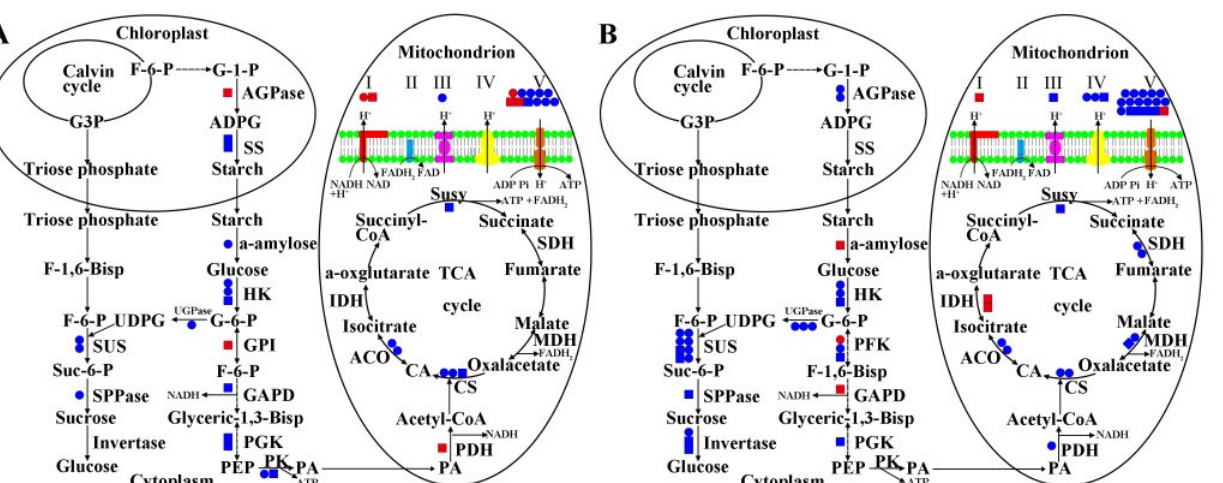
respectively (Figure 5). The gene expression and protein quantity of 6-phosphofructokinase (PFK) were downregulated and decreased at the TE and BI stages, respectively. However, a gene-encoding PFK was upregulated at the BI stage. The gene expression and protein quantity of pyruvate kinase (PK) were downregulated and decreased at the TE